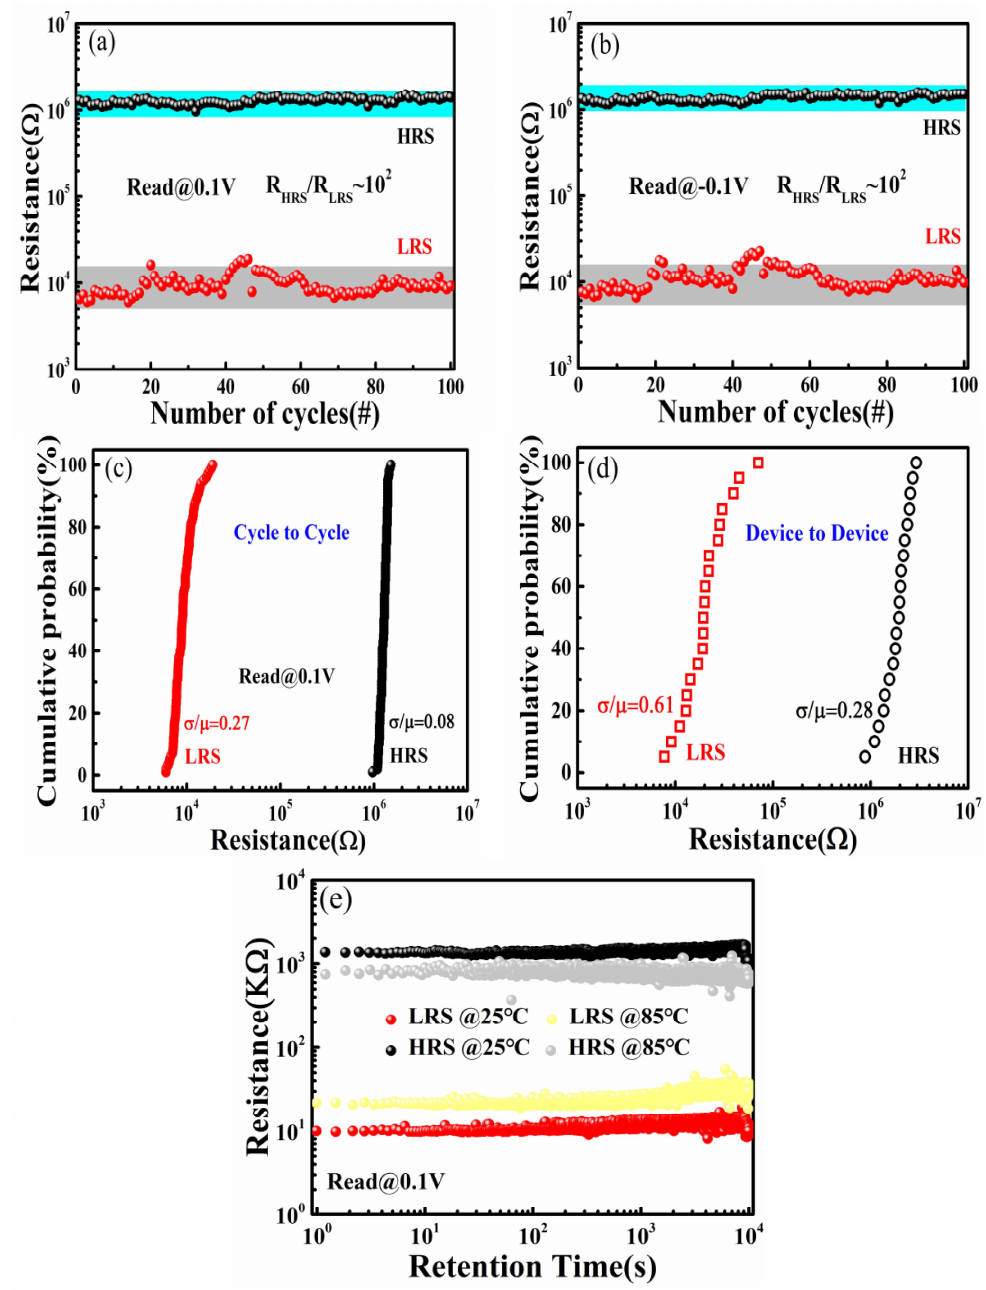
Figure 4. Endurance and retention test results of the device. The HRS and LRS read at ( a ) 0.1 V and ( b ) − 0.1 V for 100 cycles. The cycle-to-cycle distribution of HRS and LRS for 100 cycles in ( c ), device-to-device distribution of HRS and LRS for 20 devices in ( d ), the retention characteristics of ( e ), and HRS and LRS at room temperature (25 ◦ C) and 85 ◦